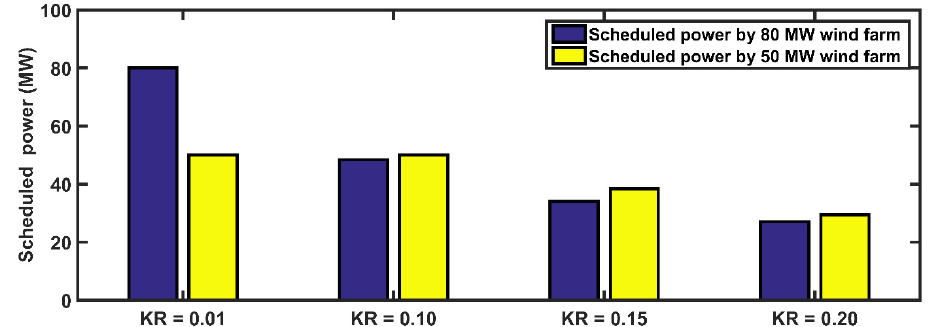
Figure 12. Optimal scheduled power (MW) versus K R .